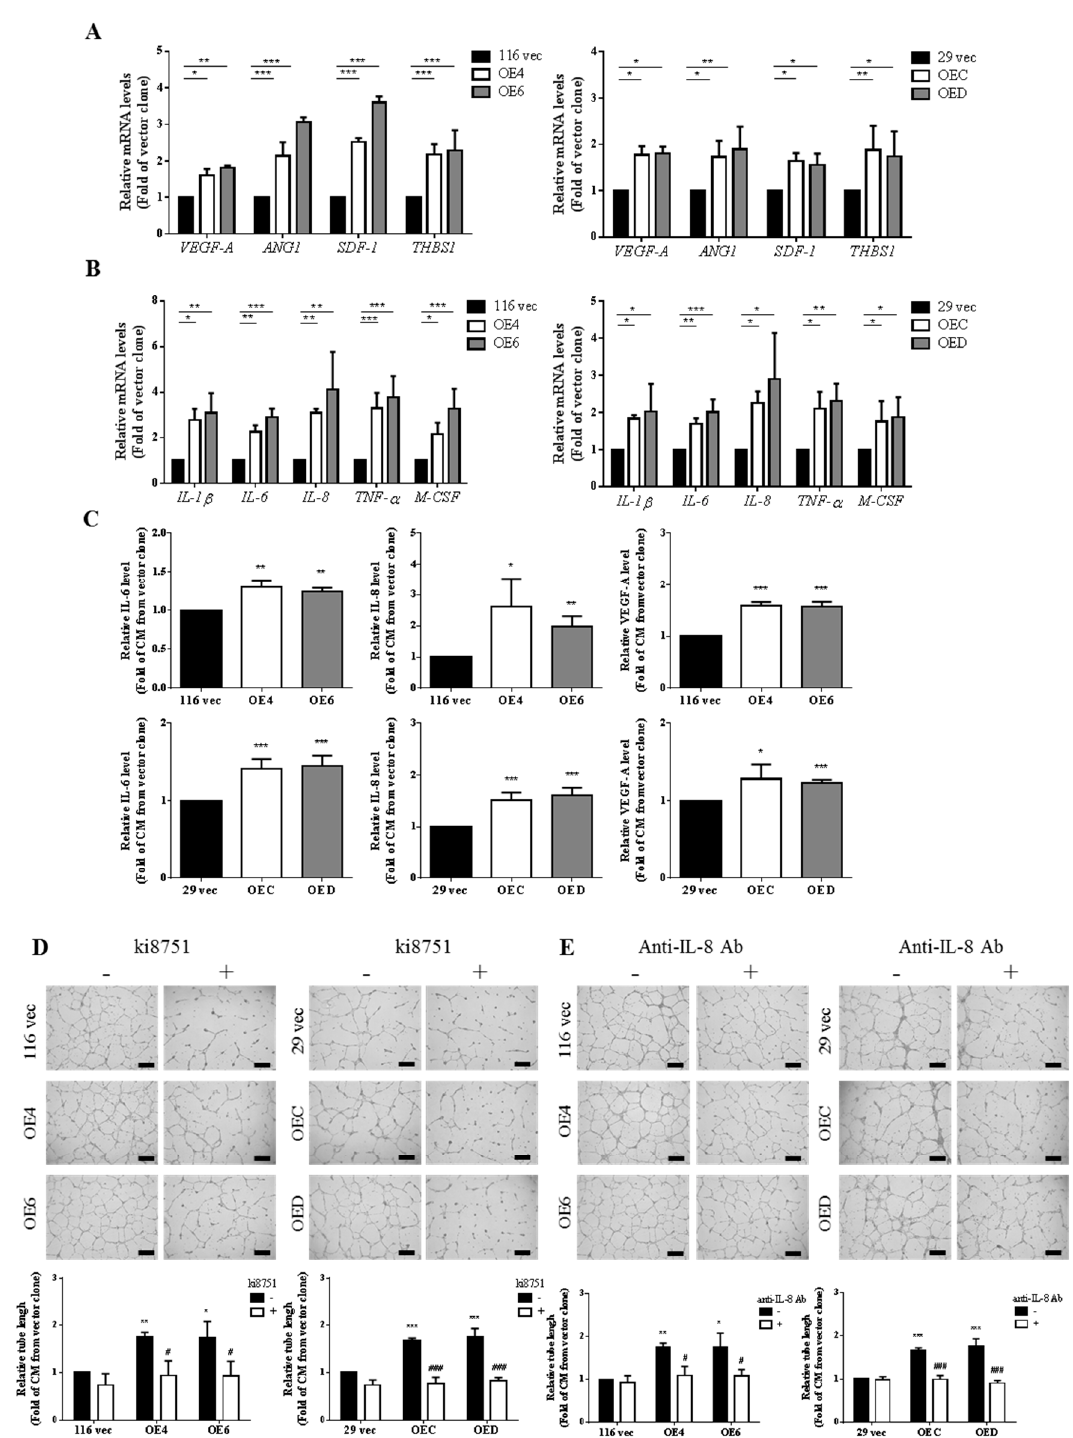
Figure 3. Both VEGF-A and IL-8 are the key proangiogenic factors produced by the GATA6-overexpressing human CRC clones. ( A ) The mRNA levels of various pro-angiogenic factor genes including VEGF-A , ANG1 , SDF-1 , and THBS1 in the vector as well as the GATA6-overexpressing HCT-116 (left) and HT-29 (right) clones were analyzed by RT-qPCR using total RNAs isolated from them. ( B ) The mRNA levels of several cytokines genes including IL-1 β , IL-6 , IL-8 , TNF- α , and M-CSF in the vector as well as the GATA6-overexpressing HCT-116 (left) and HT-29 (right) clones were examined by RT-qPCR as above described. ( C ) The levels of IL-6, IL-8, and VEGF-A in the CM collected respectively from the 116 vec, OE4, and OE6 clones (upper panels) as well as the 29 vec, OEC, and OED clones (lower panels) were analyzed by ELISA. Tube formation assays of HUVECs were carried out primarily as described above using the CM collected from three clones derived respectively from HCT-116 and HT-29 cells except that ( D ) 2 nM ki8751, a small-molecule VEGFR2 inhibitor, or ( E ) 0.1 μ g/mL of IL-8 neutralizing antibody were added into half of the samples (right panels). ( A – C ) Data are the mean